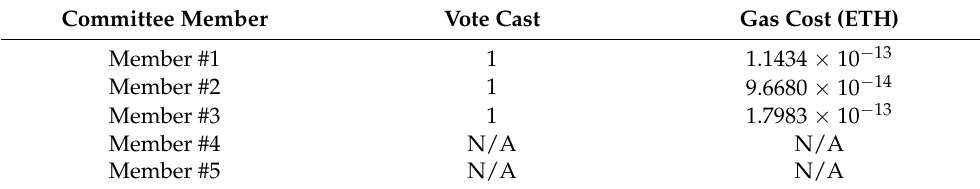
Table 4. Speedy mode votes and gas